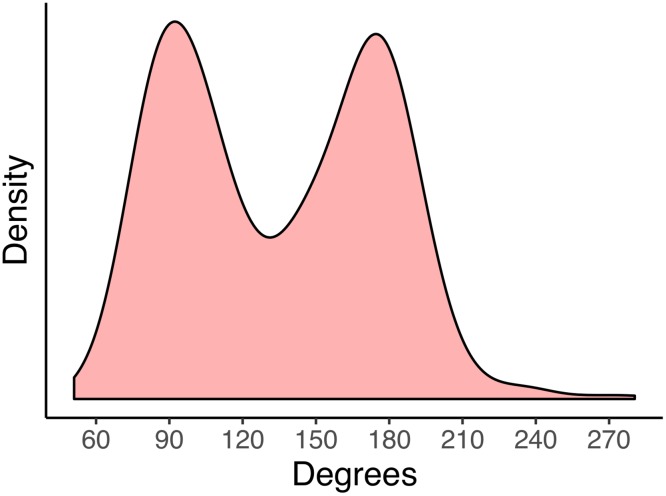
Estimated distribution of the actual amplitude in the passive rotation.(nparticipants = 49; nobservations = 578).